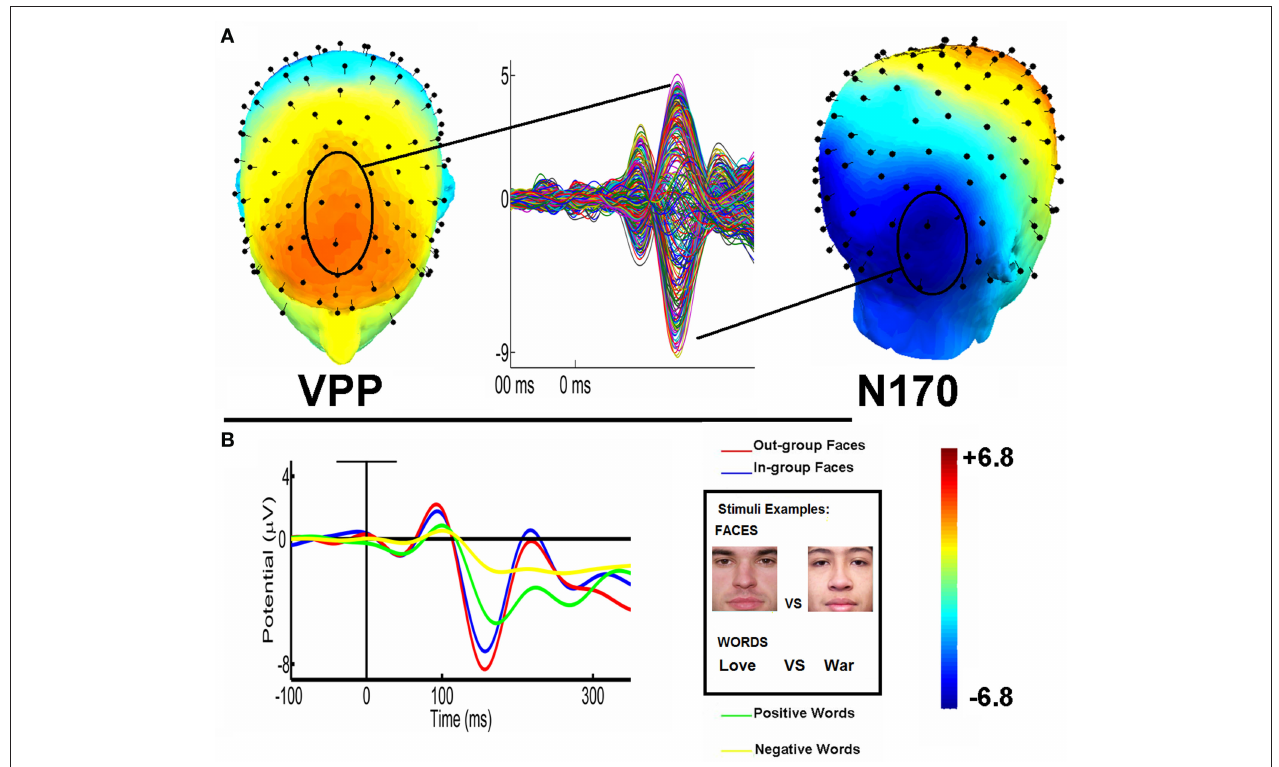
collapsed ROIs) waveforms modulated by structural features of stimuli (faces vs. words); race of the facial stimuli (ingroup vs. outgroup) and word valence (positive vs. negative). Right : Examples of stimuli (ingroup and outgroup relative position faces; positive vs. negative